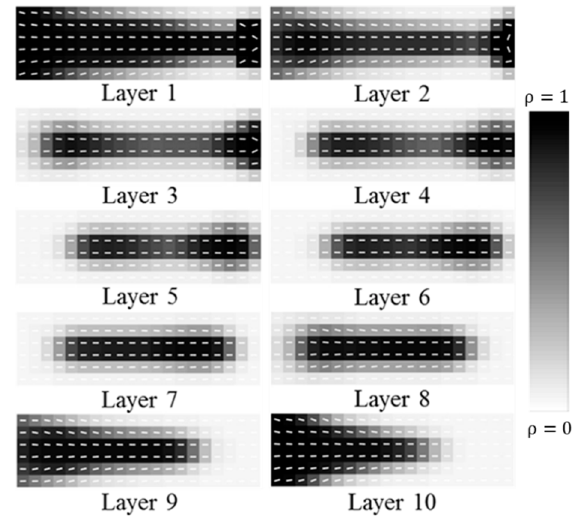
Figure 14. Optimized material distribution and material orientation, layer-by-layer plots for Case 2. Layer 1 corresponds to the bottom layer, and layer 10 corresponds to the top layer.